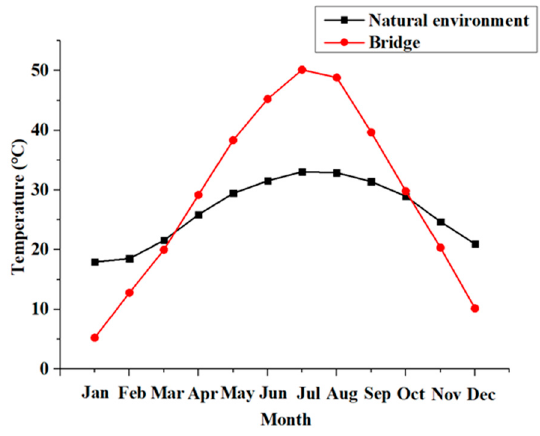
Figure 7. Annual temperature cycle.